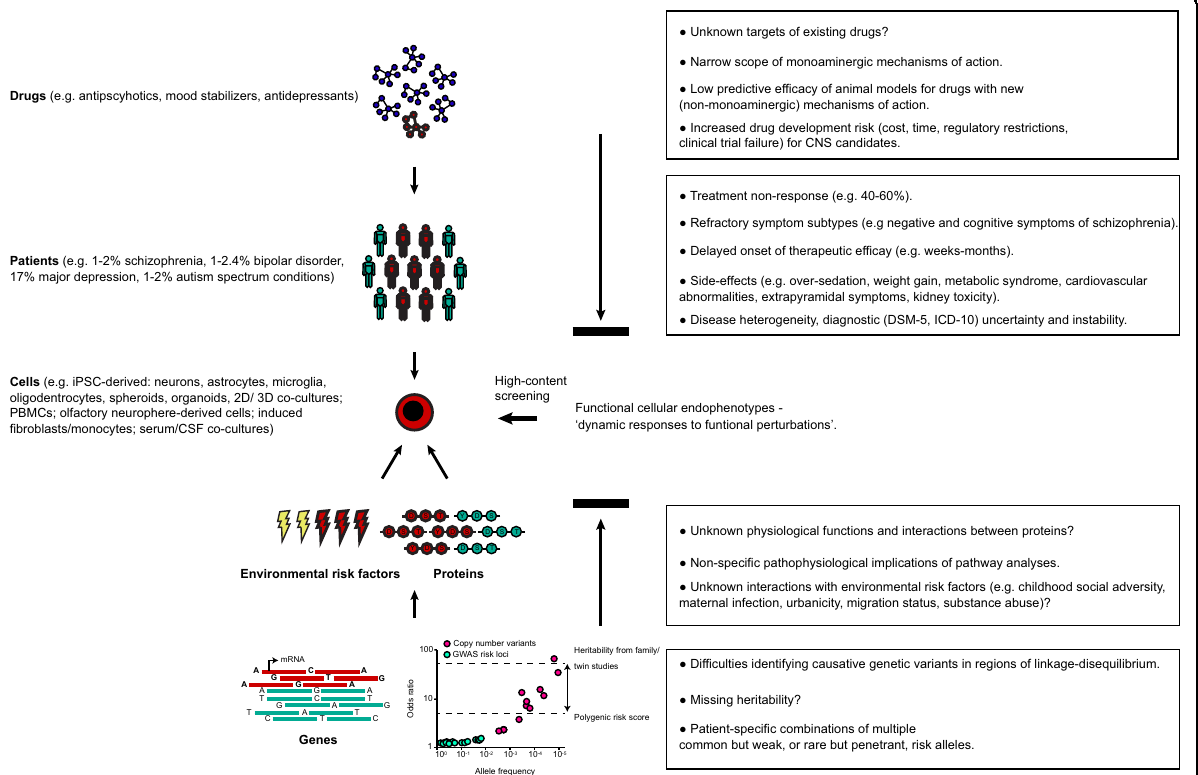
Fig. 1 Translation gap in neuropsychiatric drug discovery. The fi gure summarizes the major obstacles and pending questions in neuropsychiatric drug discovery (boxes right) at the drug, patient, environmental risk factor, protein and gene levels. Disease heterogeneity, diagnostic uncertainty and incomplete characterization of the molecular targets of current neuropsychiatric medications have led to many patients who either do not respond to treatment, present with treatment-refractory symptom domains or suffer from debilitating side effects. On the other hand, the genomic complexity of neuropsychiatric disorders, in terms of multiple common but weak or rare but penetrant risk alleles (shows schematic distribution of allele frequencies vs. odds ratios for GWAS risk loci and copy number variants adapted from ref. 3 ), unknown susceptibility loci (missing heritability) and uncharacterized interactions between genetic and environmental risk factors, in addition to incomplete functional annotation of protein interaction databases, has made it dif fi cult to accurately prioritize potential drug targets at the cellular level based on molecular pro fi ling data. Functional testing of patient and control cells using ligand libraries and high-content screening provides a means to summarize the integrated effects of multiple molecular and environmental risk factors (red) as convergent abnormalities in cellular response ( ‘ functional endophenotypes ’ ) which may represent more physiologically relevant drug targets for speci fi c patient